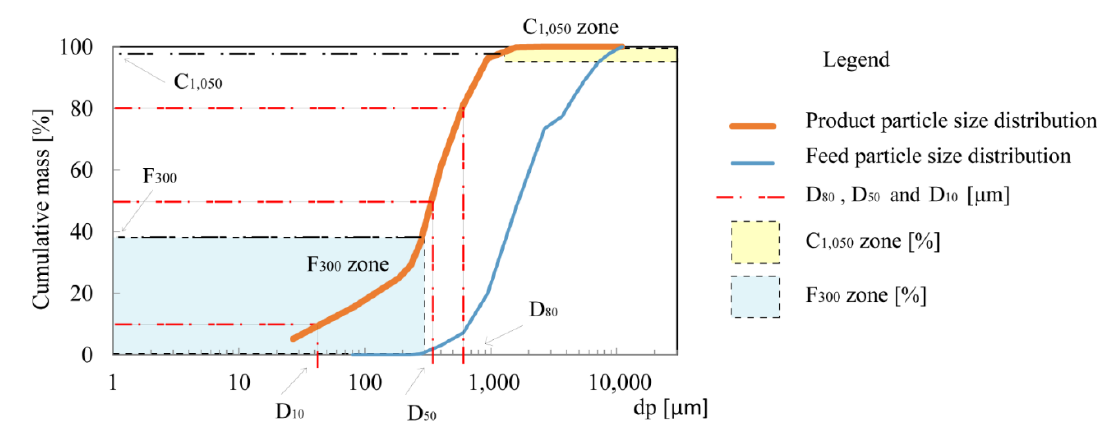
Figure 1. Main parameters used in this work with the aim of analyzing rod milling .